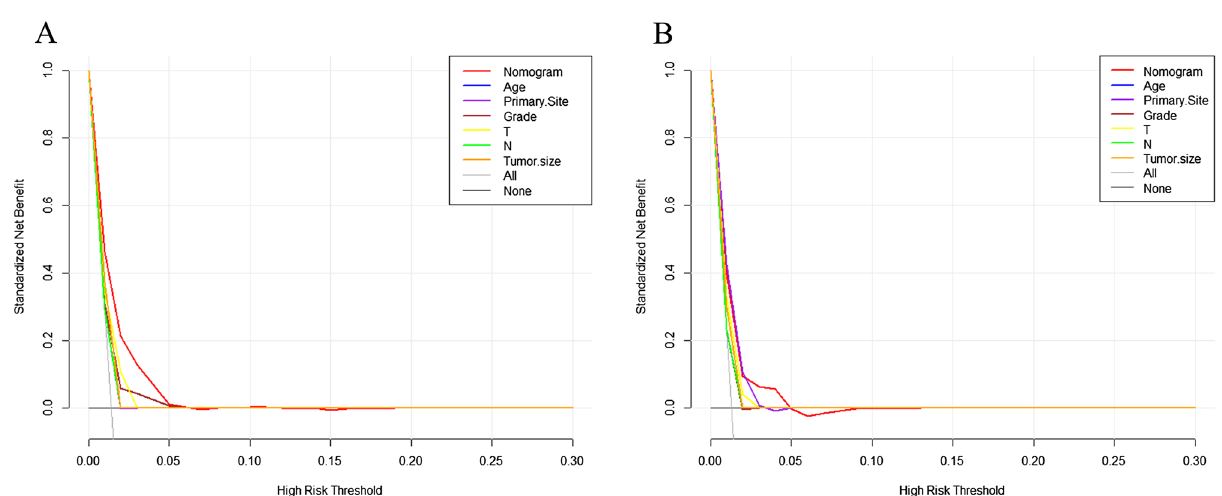
Figure 3. Comparison of decision curve analysis between the diagnostic nomogram and single independent factors in the training set ( A ) and validation set ( B